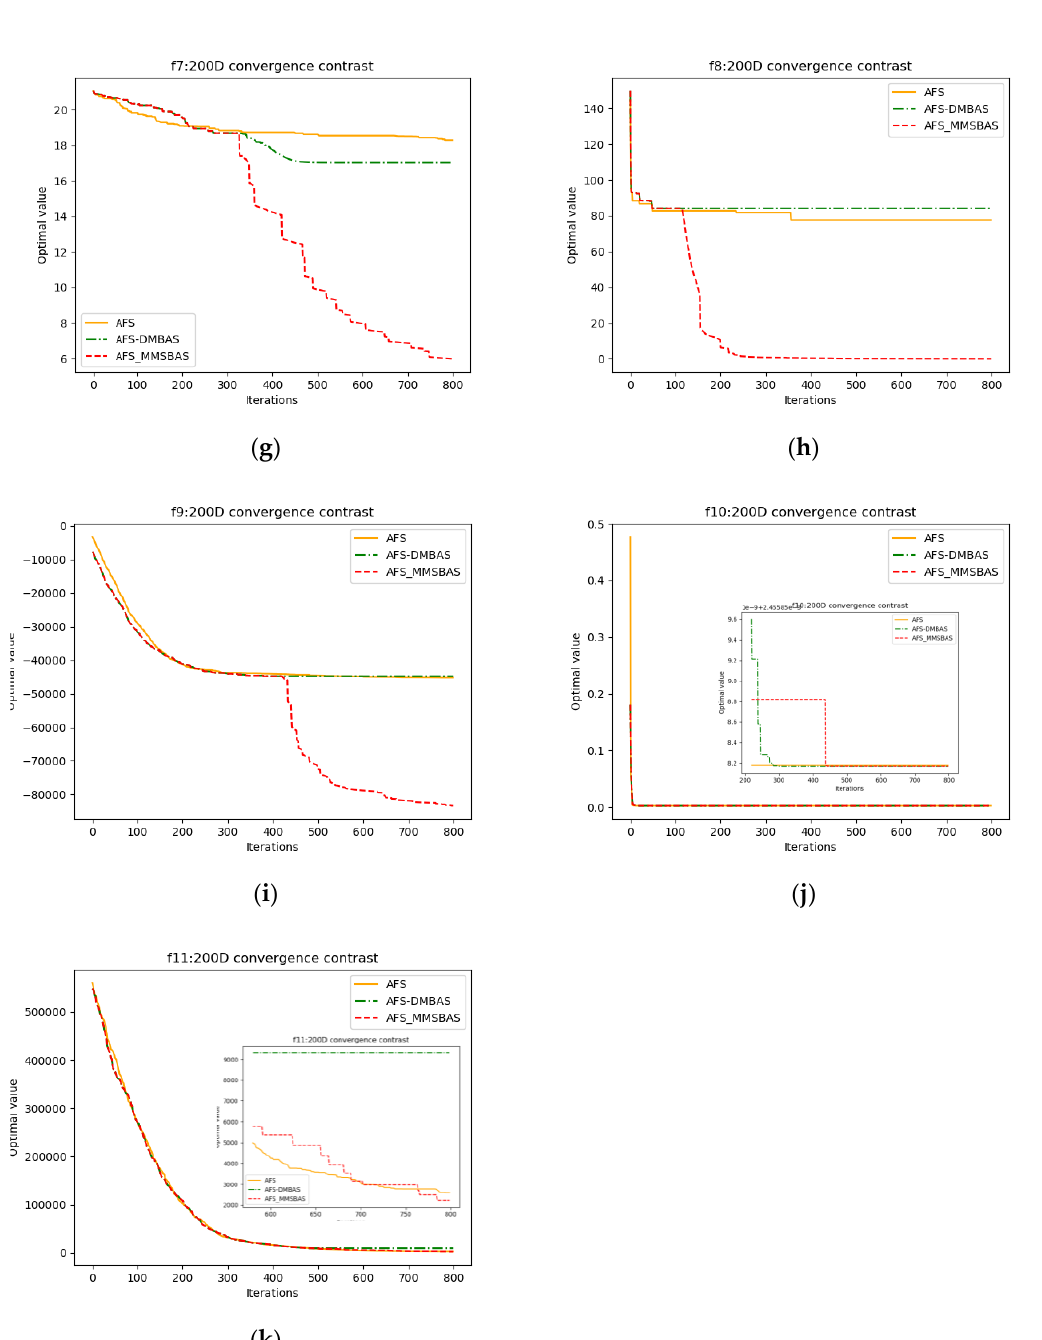
Figure 6. D = 200, functions f 1 ∼ f 11 convergence performance. ( a ) Comparison of convergence of three algorithms for function f 1 ; ( b ) Comparison of convergence of three algorithms for function f 2 ; ( c ) Comparison of convergence of three algorithms for function f 3 ; ( d ) Comparison of convergence of three algorithms for function f 4 ; ( e ) Comparison of convergence of three algorithms for function f 5 ; ( f ) Comparison of convergence of three algorithms for function f 6 ; ( g ) Comparison of convergence of three algorithms for function f 7 ; ( h ) Comparison of convergence of three algorithms for function f 8 ; ( i ) Comparison of convergence of three algorithms for function f 9 ; ( j ) Comparison of convergence of three algorithms for function f 10 ; ( k ) Comparison of convergence of three algorithms for function f 11